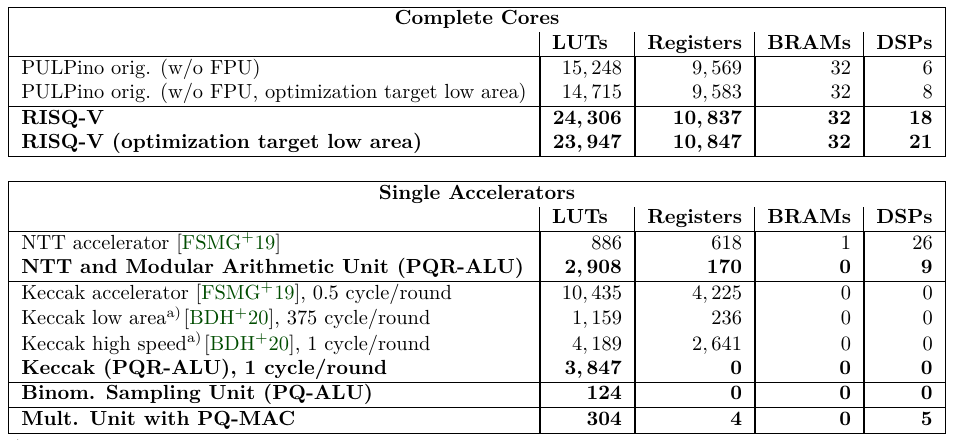
Table 7: Resource utilization FPGA (synthesis optimization settings default if not otherwise